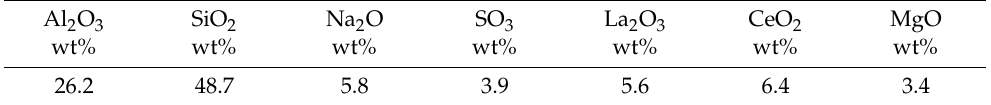
Table 1. Chemical composition (wt%) analysis table of each component of silica-rich waste powder.